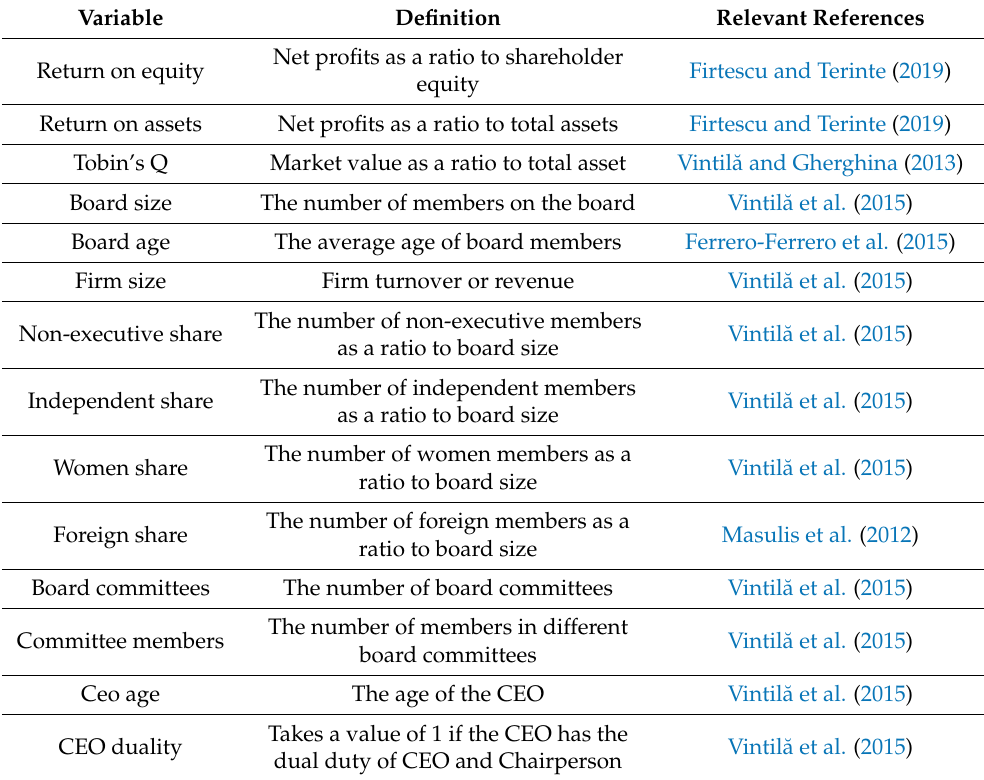
Table 1. Description of